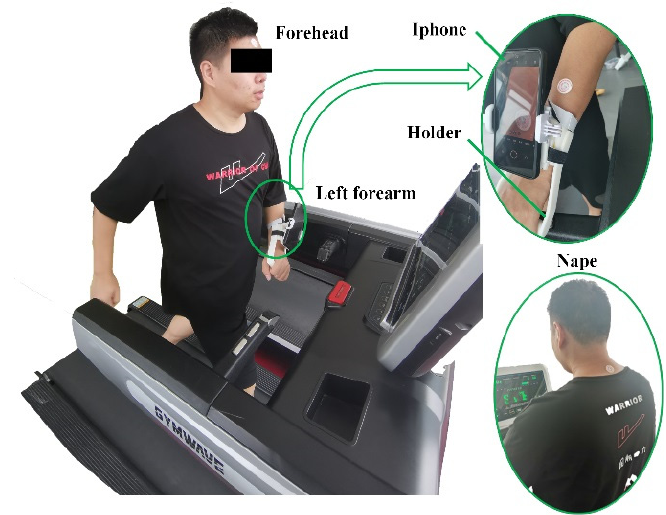
Figure 4. Experimental setup involving a male volunteer running under controlled conditions with chips located on the forehead, left forearm, and nape of the neck.